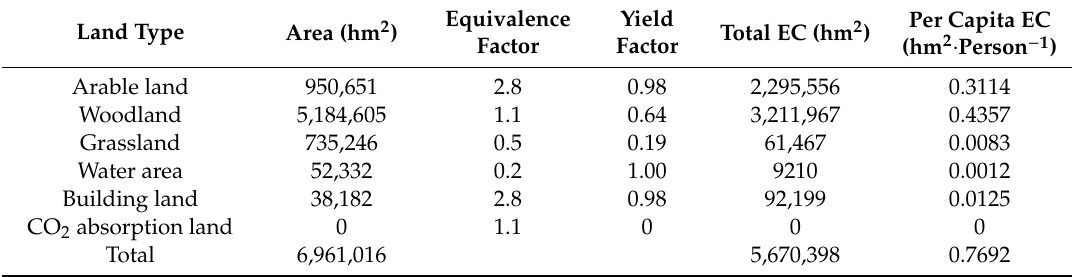
Table 5. The ecological carrying capacity (EC) in northwestern Guangxi in